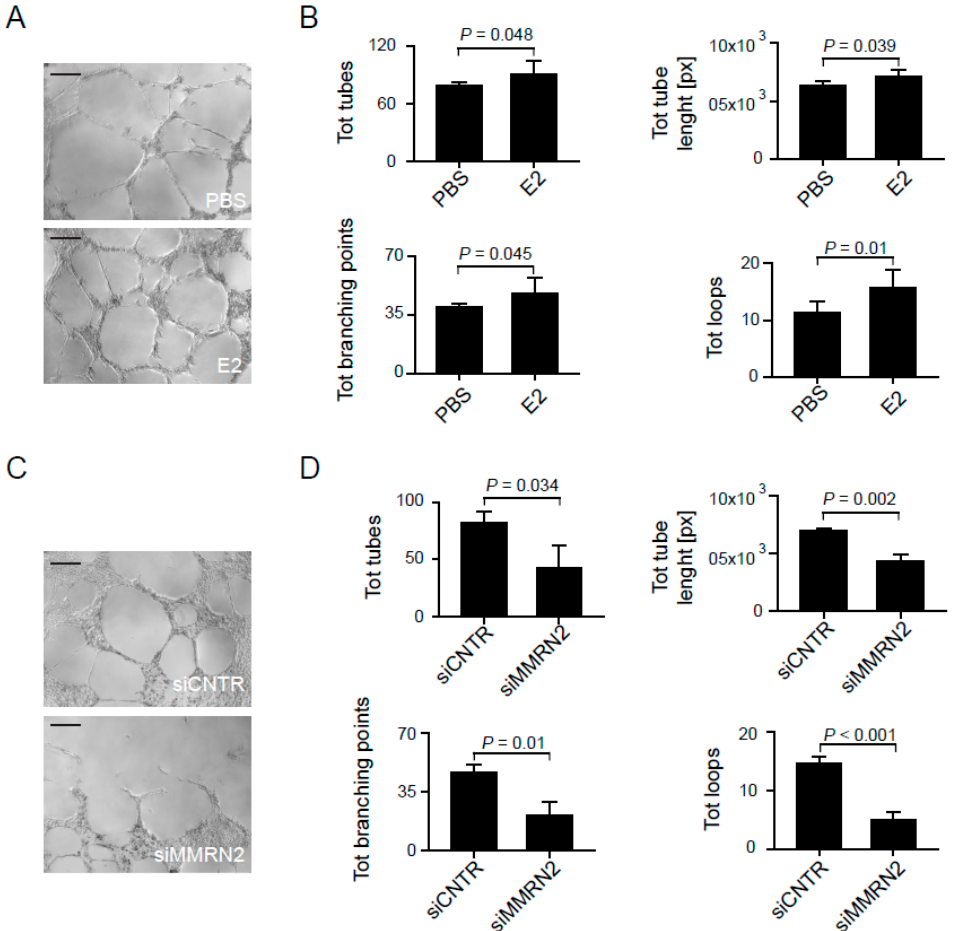
Figure 6. Multimerin-2 and EMILIN-2 expression impact on the angiogenic response in the gastric cancer environment. ( A ) Representative images of the tubes formed by HUVEC cells placed on MATRIGEL ® and challenged with conditioned media from AGS cells following the addiction of recombinant EMILIN-2 (E2) or an equal volume of PBS; scale bar = 100 μ m. ( B ) Quantification of the total of tubes, total branching points, total tubes length and total loops of the experiment reported in A; [px]: pixels. ( C ) Representative images of the tubes formed by HUVEC cells placed on MATRIGEL ® and challenged with conditioned media from AGS following transduction with the control (siCNTR) or Multimerin-2 specific (siMMRN2) siRNA adenoviral constructs; scale bar = 100 µ m. ( D ) Quantification of the total tubes, total branching points, total tubes length and total loops of the experiment reported in C. Graphs represent the mean ± SD; p values were obtained using the paired Student’s t